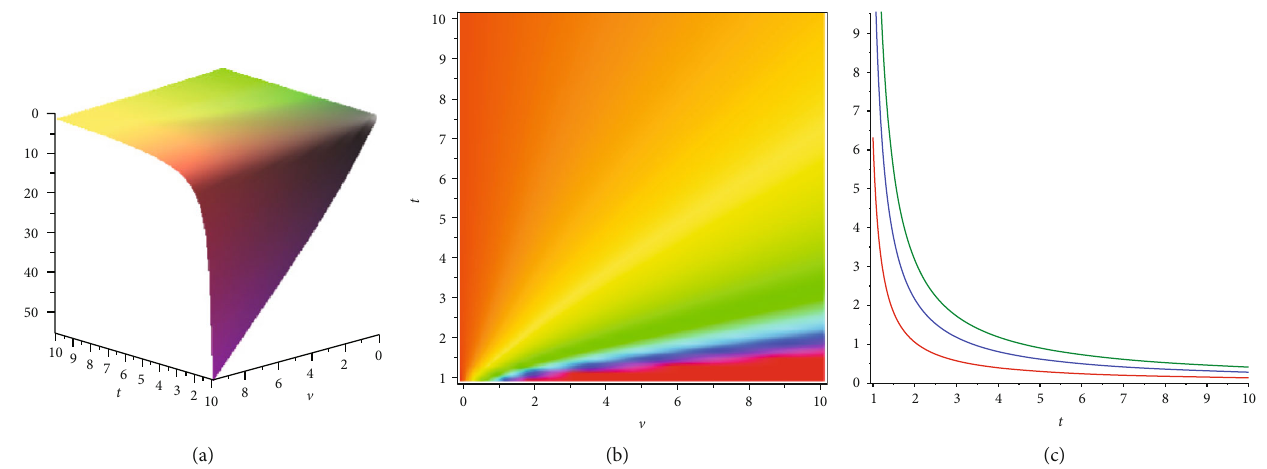
Figure 1: Solution (25) of Equation (1) by choosing suitable parameters: p = 1 , n = 1 , and μ = 0 : 8 . (a) Perspective view. (b) Overhead view. (c) Propagation pattern of the wave along the t